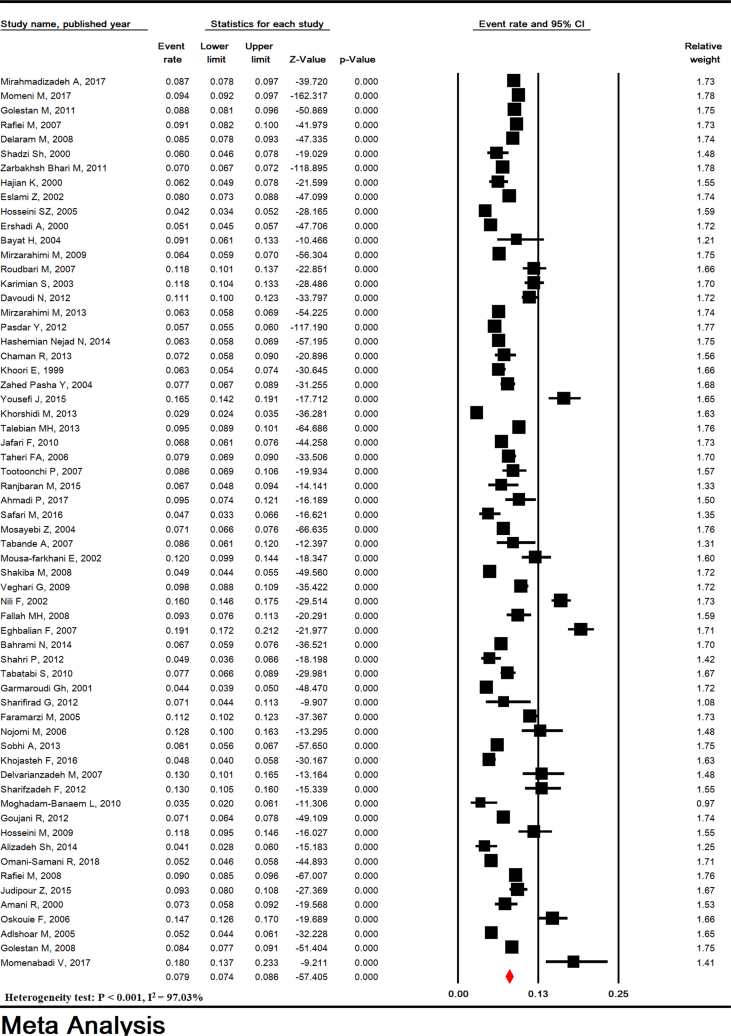
Prevalence of low birth weight in Iran.